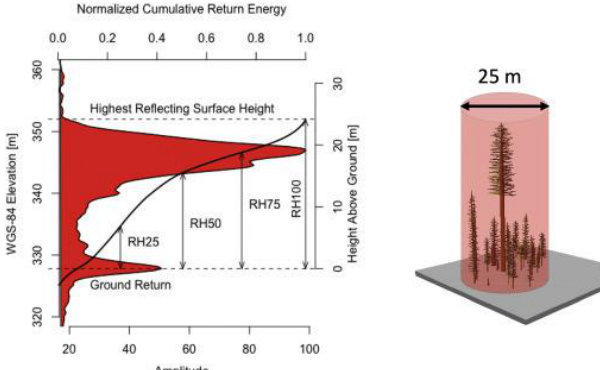
Figure 3. GEDI footprint schema with example of full- waveform return from Dubayah et al., (2020).